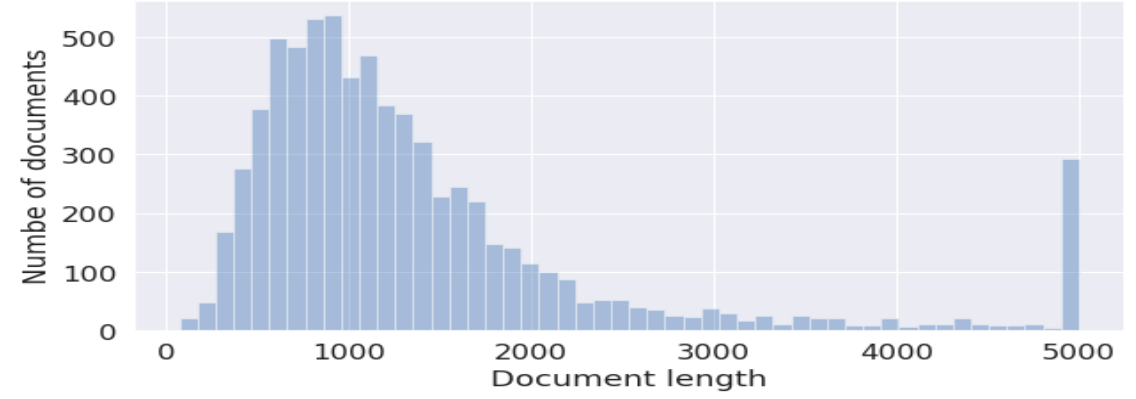
Figure 2. Distribution of words in the corpus.